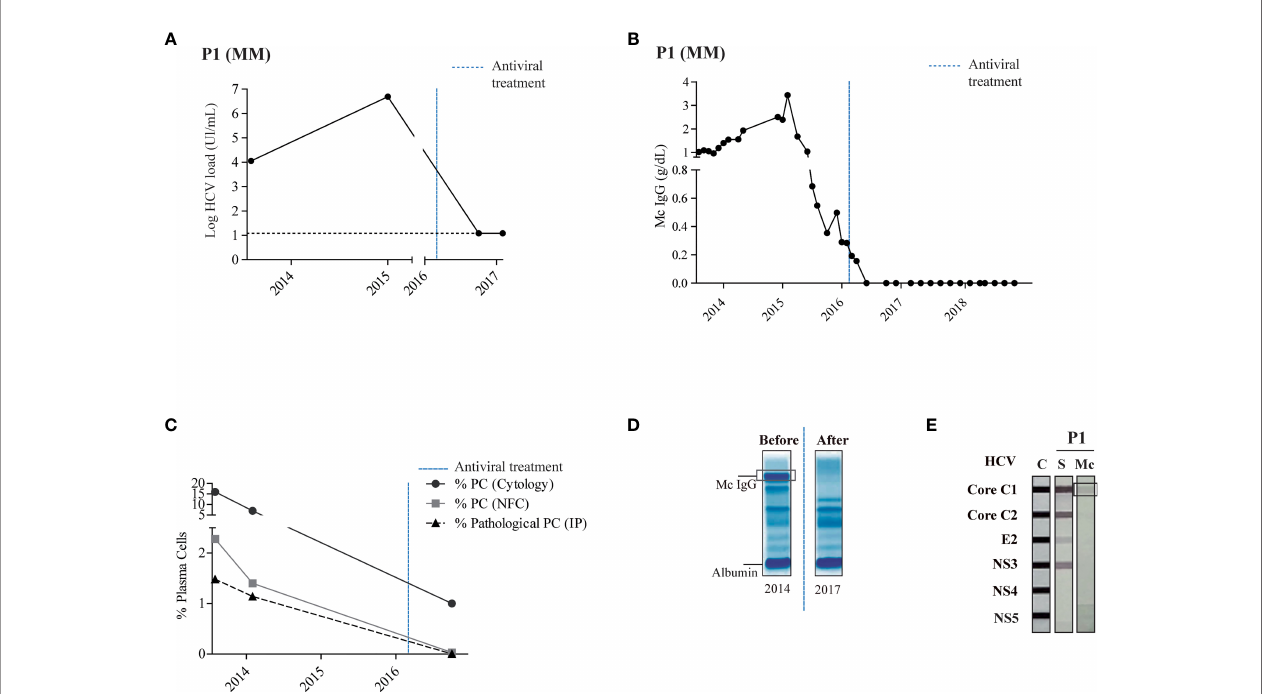
FIGURE 1 | Stable complete remission and speci fi c recognition of HCV in a patient with MM treated with antiviral drugs. Panel (A) shows the HCV load quanti fi ed by reverse-transcriptase quantitative polymerase chain reaction in the patient ’ s serum. The black horizontal dotted line represents the threshold of virus detection. Panel (B) shows the quantity of monoclonal IgG as determined by serum protein electrophoresis. Panel (C) shows the percentage of plasma cells determined by bone marrow examination (cytology) or next generation 8-color multiparametric fl ow cytometry, and the percentage of pathological plasma cells as determined by immunophenotyping. (A – D) The blue vertical dotted line indicates the time of antiviral treatment. Panel (D) shows a representative agarose gel electrophoresis of polyclonal Igs in serum before (2014) and after (2017) antiviral treatment – the encircled band corresponds to the patient ’ s monoclonal Ig. Panel (E) shows the INNO- LIA ™ HCV test and immunoblotting assay used to detect reactivity of the patient ’ s serum IgG and of the puri fi ed monoclonal IgG against different HCV proteins. The signal obtained with HCV core for the monoclonal IgG of patient P1 was weak but always reproducible when different preparations of the puri fi ed monoclonal IgG were tested. C, positive controls; S, serum; Mc, monoclonal